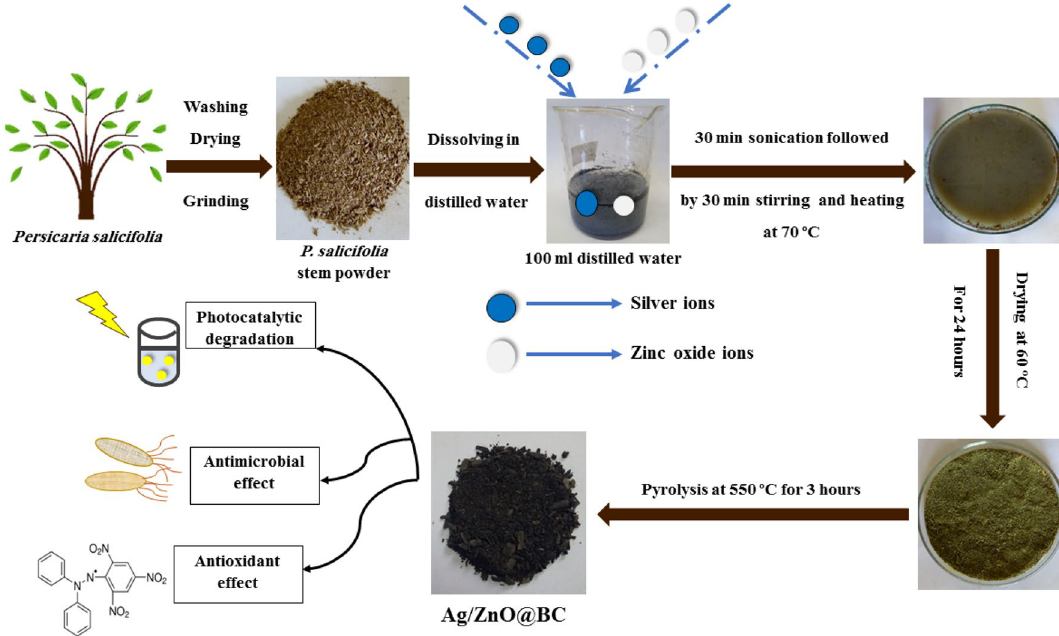
Figure 1. Schematic illustration of the green synthesis of